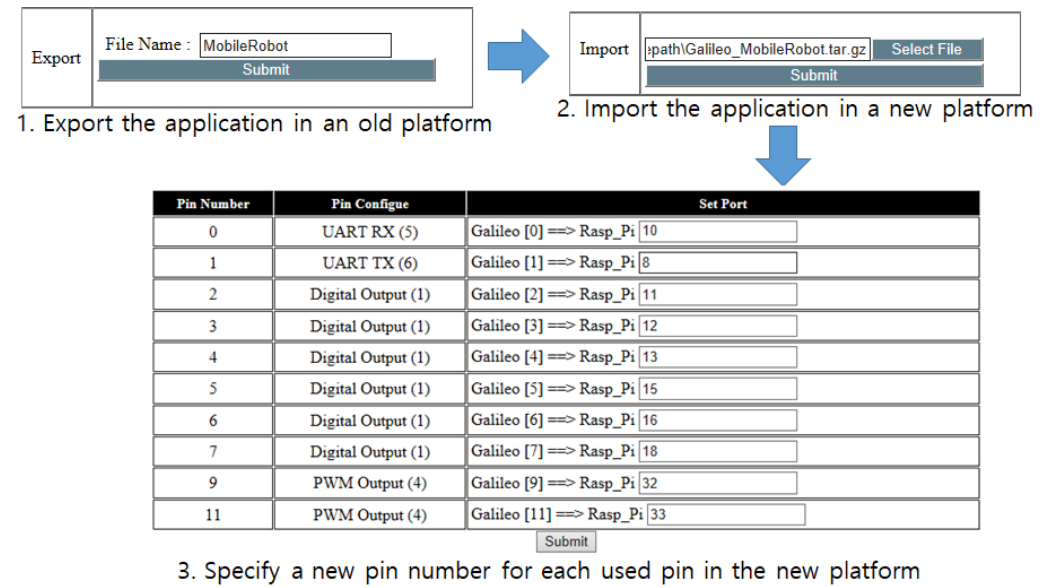
Figure 10. Porting the mobile robot control application for Galileo Gen 2 to Raspberry